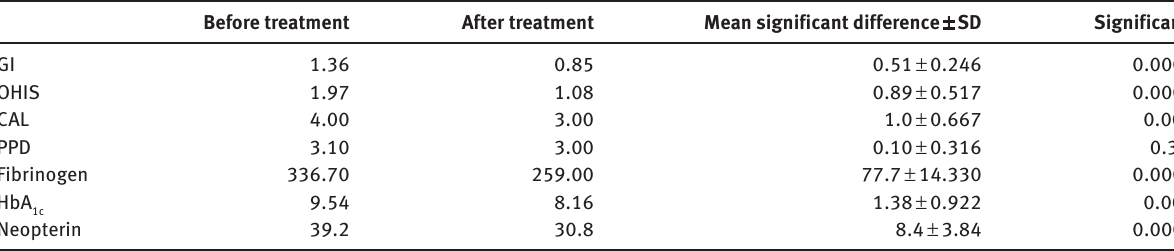
Table 3: Intragroup comparison of all variables before and after treatment in group D.